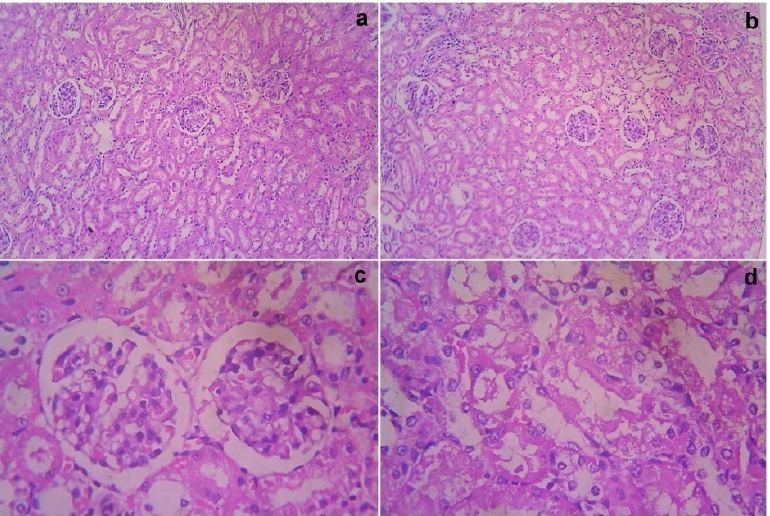
Figure 5. Gross histopathological examination of the kidney following the infusion of mesenchymal stem cells obtained from decidua basalis in Wistar albino rats to assess the impact of safety, efficacy, and acute toxicity. Representative images of the kidney section stand for ( a ) 10× showing the kidney with both the cortex and medulla, ( b ) 10× showing normal glomeruli and tubules with interstitial inflammation, ( c ) 40× showing normal glomeruli and tubules showing focal mild epithelial loss, and ( d ) 40× showing tubular epithelial thinning, respectively. Table 3. Summary of tumorigenicity.